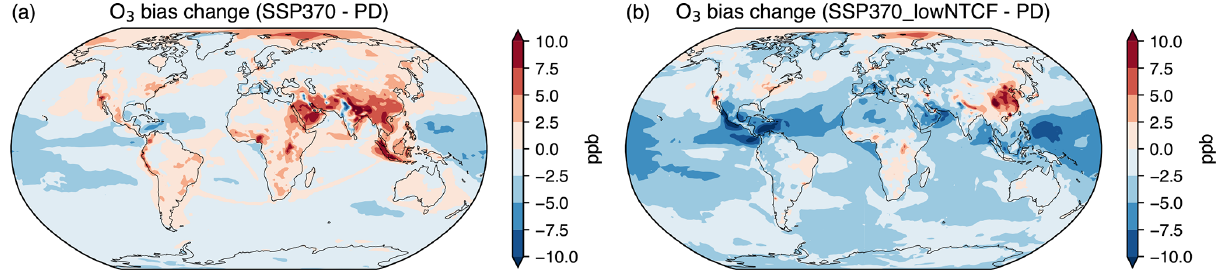
Figure 7. Annual mean change in surface O 3 biases (ppb) between the present day (PD) and 2045–2055 under (a) SSP3-7.0 and (b) SSP3- 7.0-lowNTCF pathways.